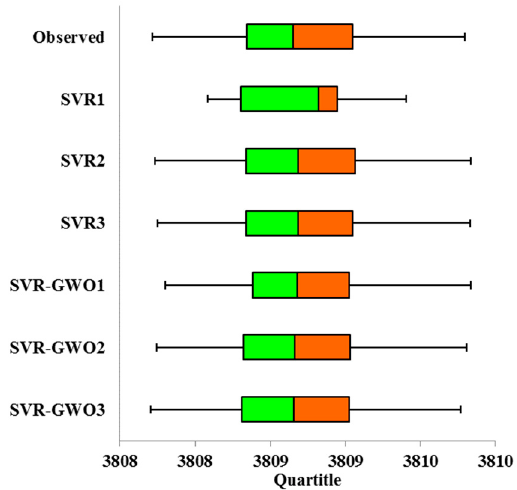
Figure 9. Box plot of observed and predicted lake water level for the testing period of the SVR and SVR-GWO models in all scenarios.